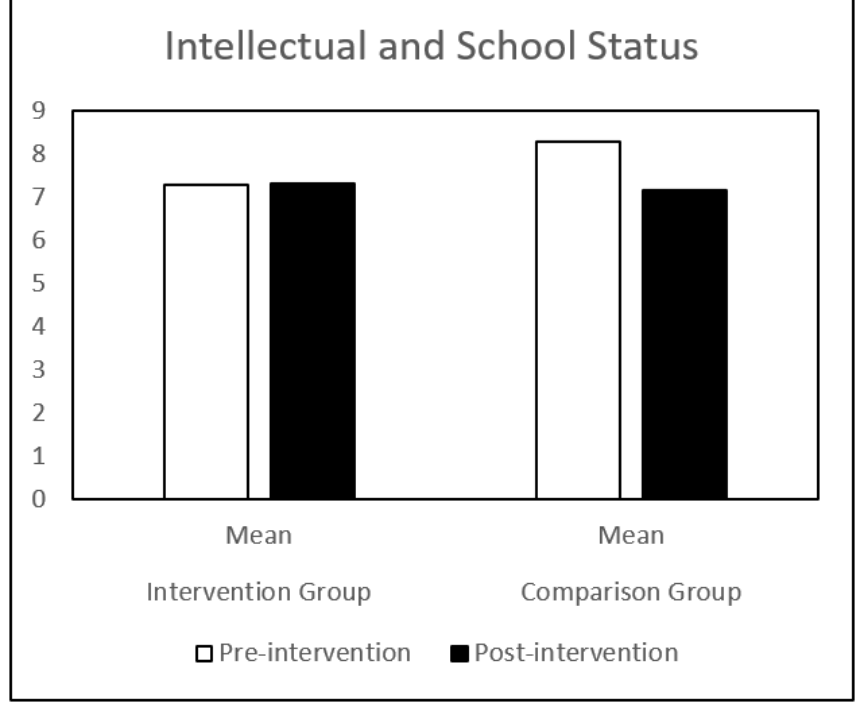
Figure 1. Behavioral Adjustment mean in IG and CG at pre- and post-intervention.